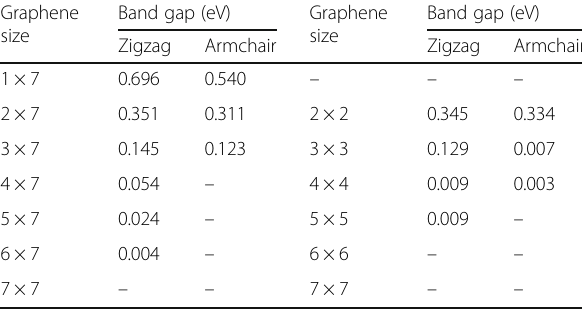
Table 1 The band gap of zigzag and armchair graphenes in various widths